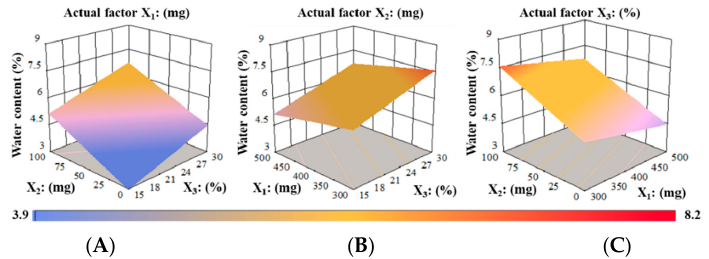
Figure 8. 3D surface models describing the influence of ( A ) PUL (X 1 ), ( B ) MTX (X 2 ), and ( C ) PG (X 3 ) on water content (Y 5 ) of RZT-ODFs. on water content (Y 5 ) of Water Absorption (%)